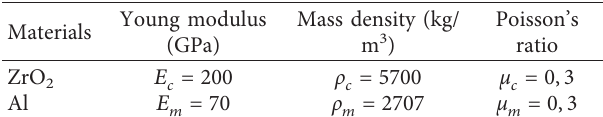
Figure 5: Deflections of the central point of the plate versus time. Table 2: Properties materials of FGM.